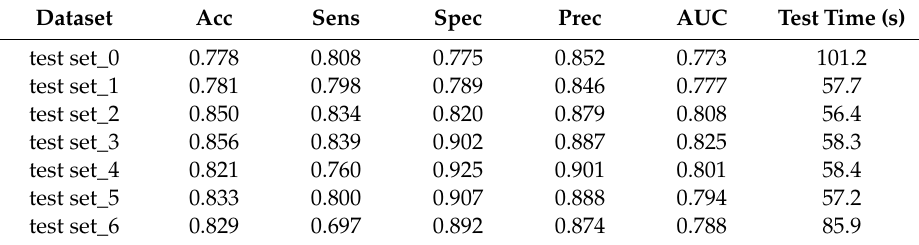
Table 8. Experimental results using IGRNet on the independent test sets.